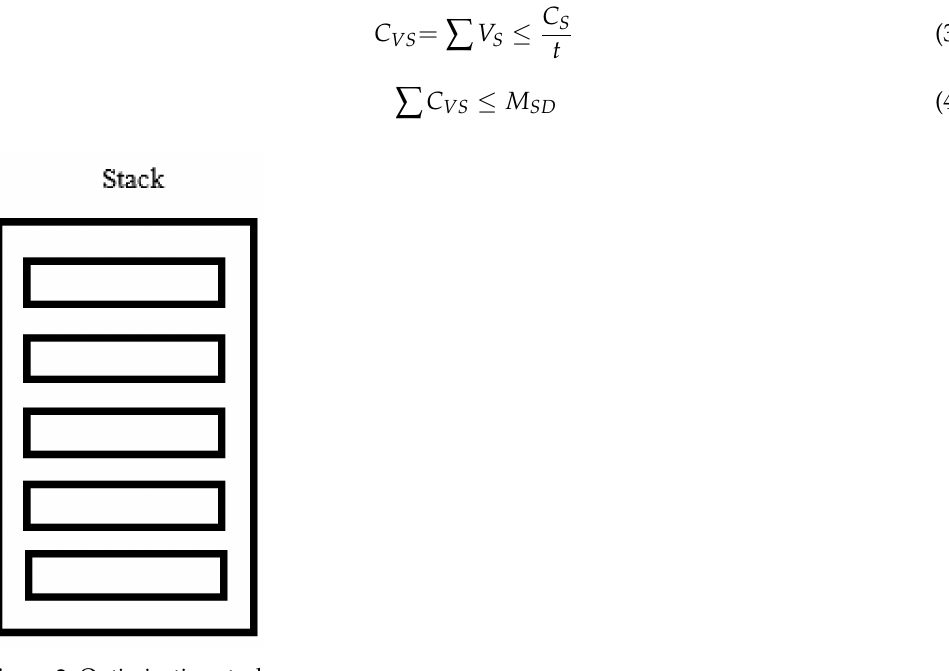
Figure 2. Optimization